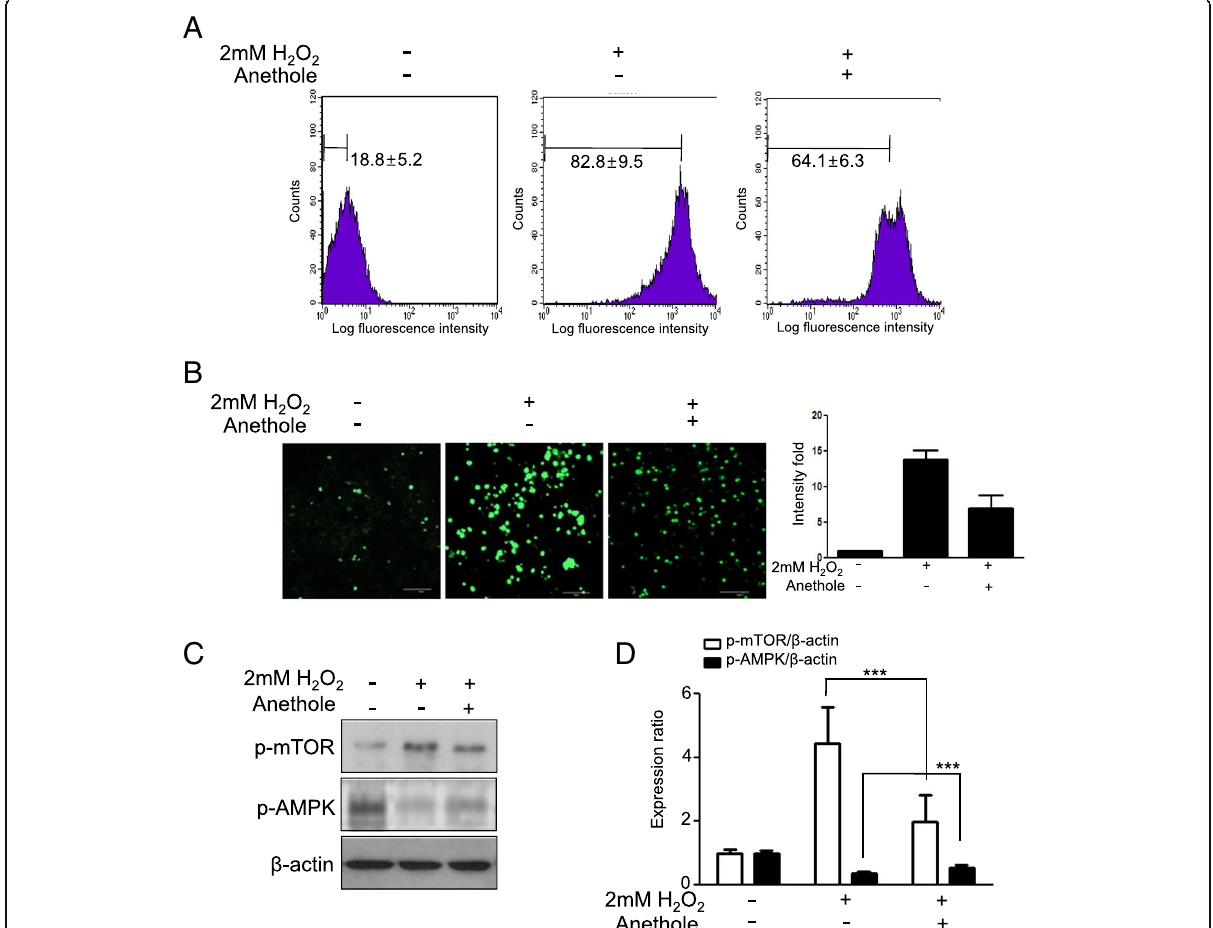
Fig. 3 Effect of anethole on excessive ROS generation in hMSCs. a hMSCs were exposed at 2 mM H 2 O 2 for 30 min and incubated for 2 days in presence or absence of 50 μ M anethole. ROS was measured by staining the cells with DCFDA cellular ROS detection assay kit according to the manufacturer ’ s instructions. After staining, cells were strained briefly and analyzed using Accuri-C6. b ROS generation was also observed under a fluorescence microscope at 200× magnification after same treatment previously described. c Whole cell pellets underwent western blot analysis for p-mTOR and p-AMPK. d Each protein expression was exhibited in the same manner as described in Fig. 3b. Each experiment was repeated three times and the values are presented as mean ± S.D. ** p < 0.05, and *** p <